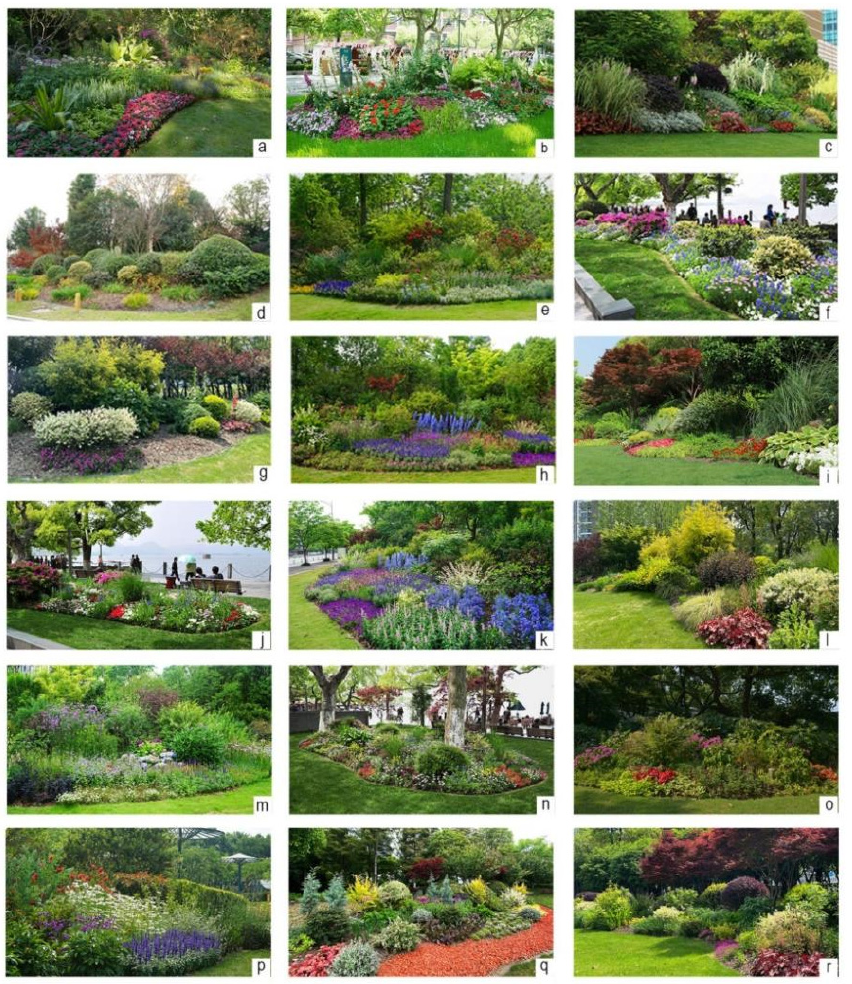
Figure 1. Representative scenes of flower borders used as visual stimuli in this study; ( a – r ) are the 18 images for this study. 18 images for this